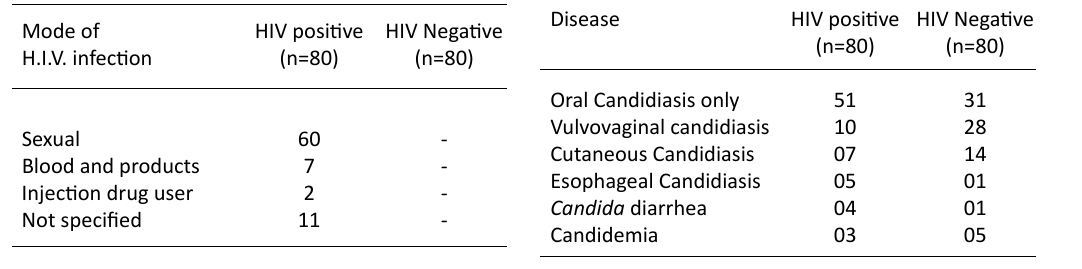
Table 3. Distribution of Various presentations